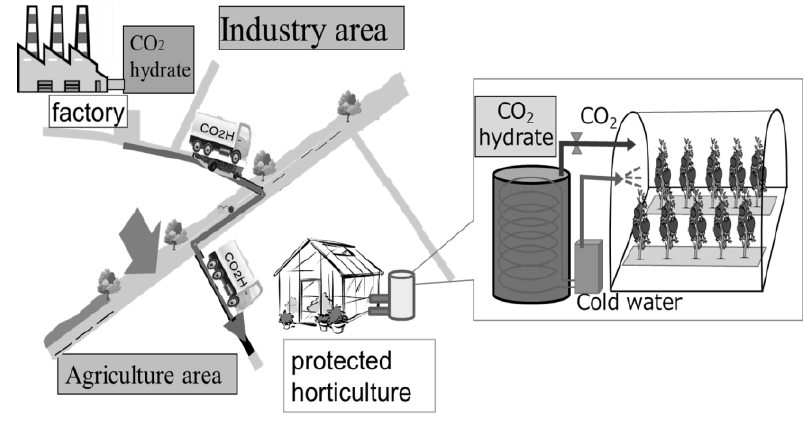
Figure 1. The agro-industrial system.